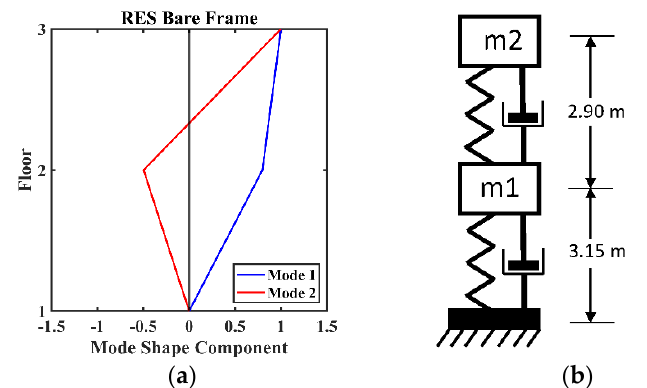
Figure 14. Mode shape and simplified concept of building RES: ( a ) first two vibration modes in the x-direction of the RES bare frame; and ( b ) 2 DOFs of RES.